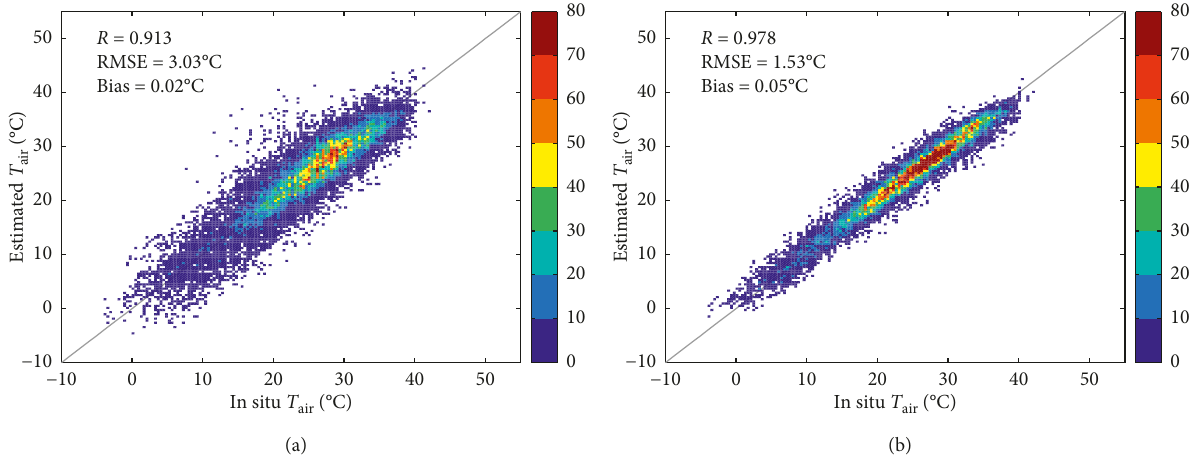
Figure 5: Two-dimensional histogram for estimated T air versus observed T air at meteorological sites when the “true” RH was used: (a) linear model 9; (b) NN model 9.